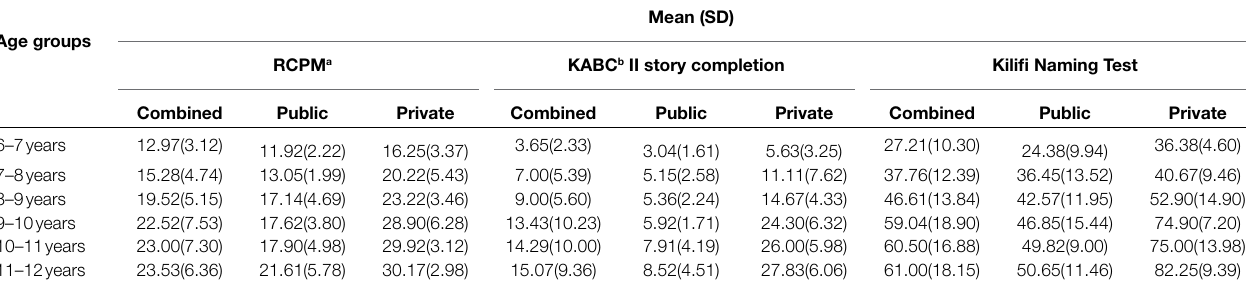
TABLE 3 | Mean and standard deviation of tests for each age